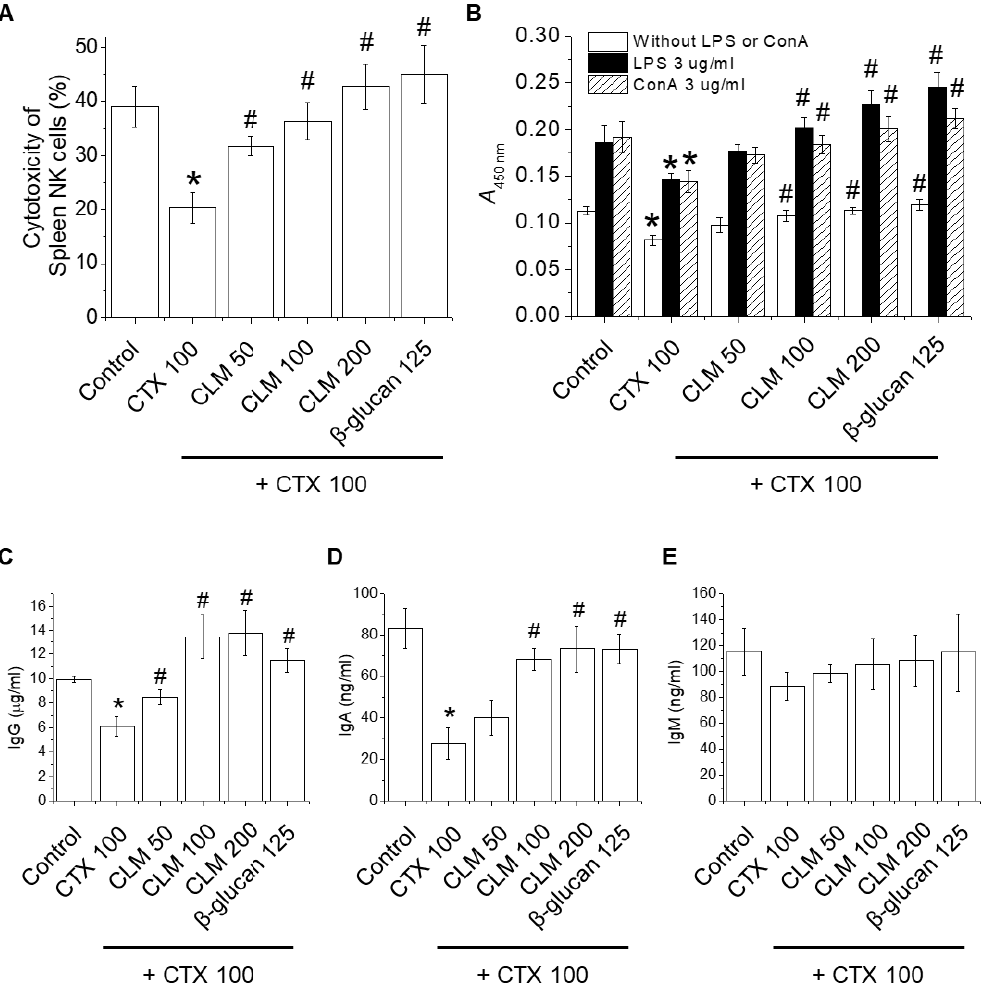
Figure 3. Effect of orally administered CLM on NK cell activity ( A ), LPS- or ConA-induced spleno- cytes proliferation ( B ), and immunoglobulin levels ( C – E ) in CTX-immunosuppressed mice. CTX- induced immunosuppressed ICR mice were treated with CLM (50, 100, and 200 mg/kg/day) for 14 days, and NK cell activity ( A ) and LPS- or ConA-induced splenocyte proliferation ( B ) were assessed. IgG ( C ), IgA ( D ), and IgM ( E ) were assayed using commercial ELISA kits. Data are expressed as mean ± SD ( n = 6). * p < 0.05 vs. control group; # p < 0.05 vs. CTX-treated group.